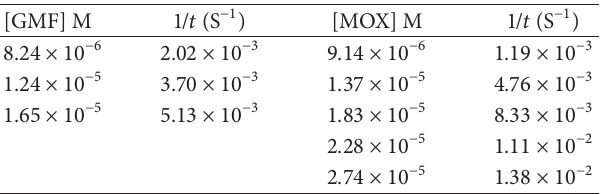
Table 5: Values of reciprocal time taken at fixed absorbance for the different rates of variable concentration of drugs at constant concentrations of NBD-Cl.